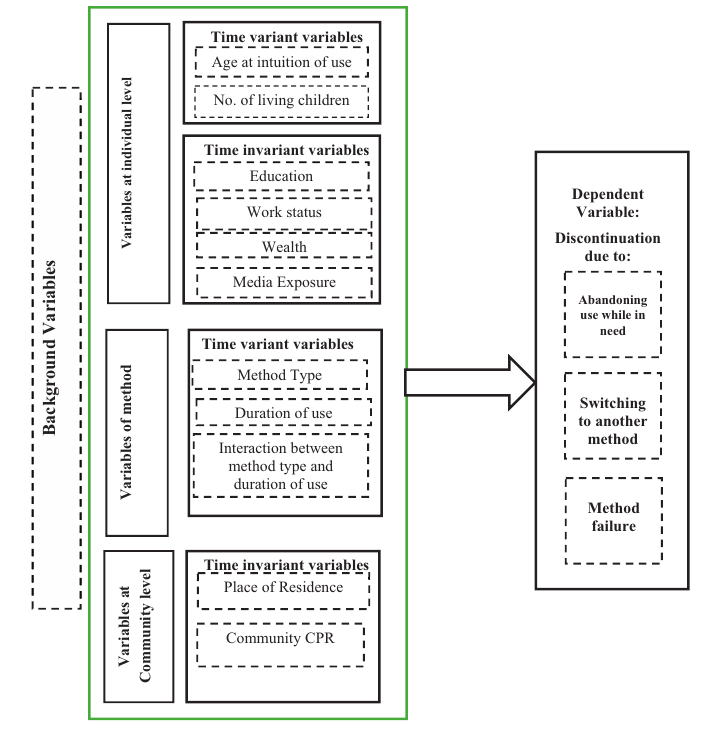
Figure 1. Theoretical framework for the factors impacting the contraceptive